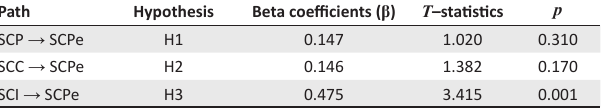
FIG URE 2: Structural model. TABLE 3: Results of structural equation model analysis.